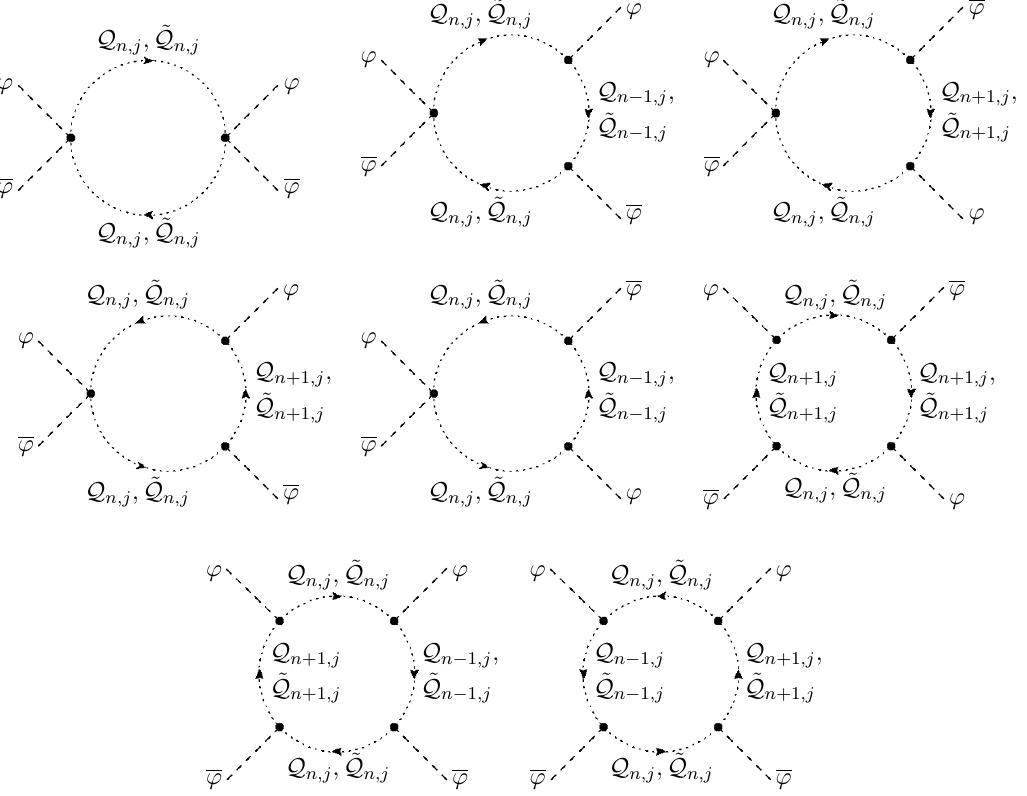
Figure 6. Bosonic contributions to the Wilson line quartic coupling with